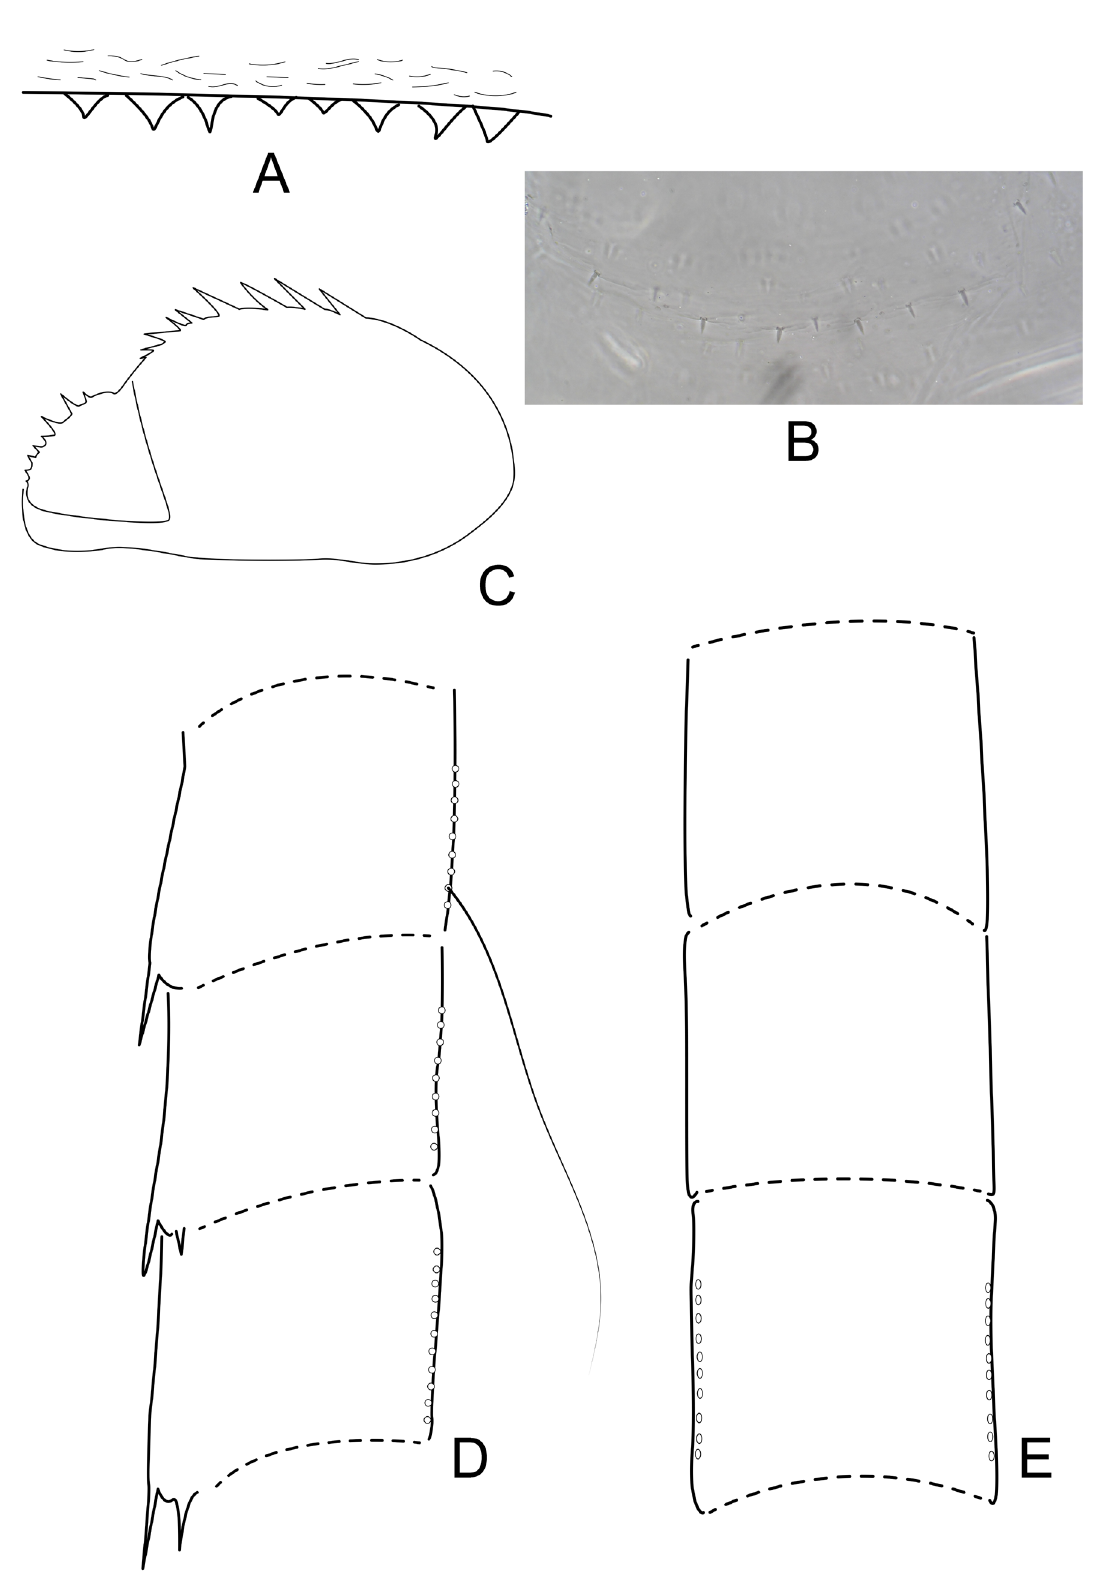
Fig. 3. Rivudiva trichobasis Lugo-Ortiz & McCafferty, 1998, paratype (IBN slide #270). A . Margin of tergum IV. B . Surface of sternum IV. C . Paraproct. D . Cercus. E . Paracercus. Not to